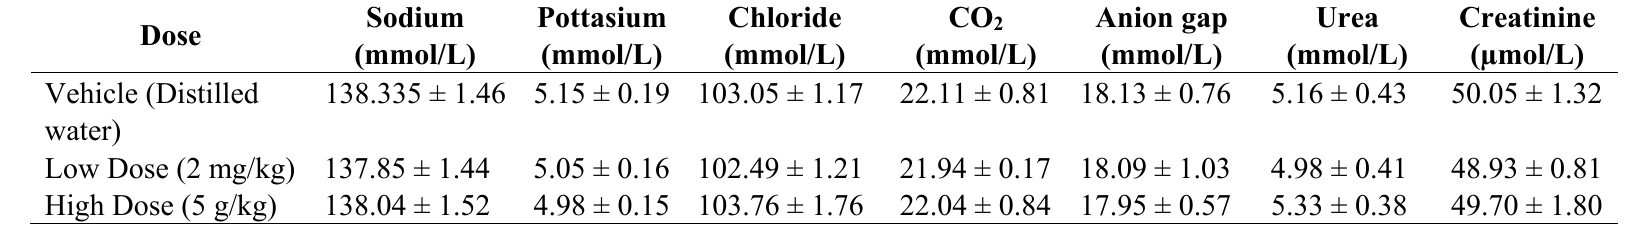
Table 5. Effect of adiponectin on renal function test in acute toxicity study.